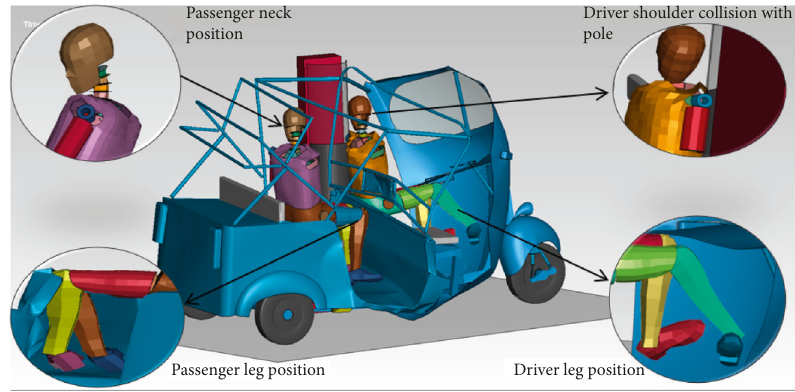
Figure 17: Occupant contact area with